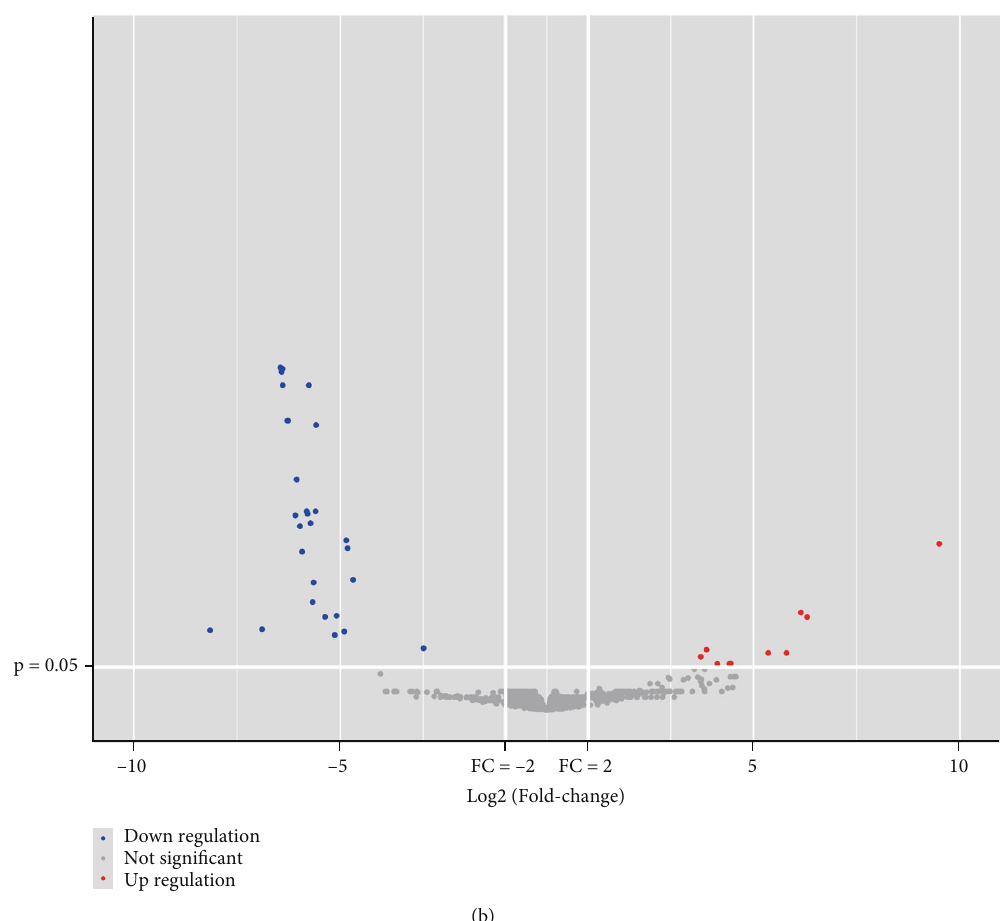
Figure 2: miRNA DEGs analysis. (a) Heat map and (b) volcano map illustrations of di ff erential